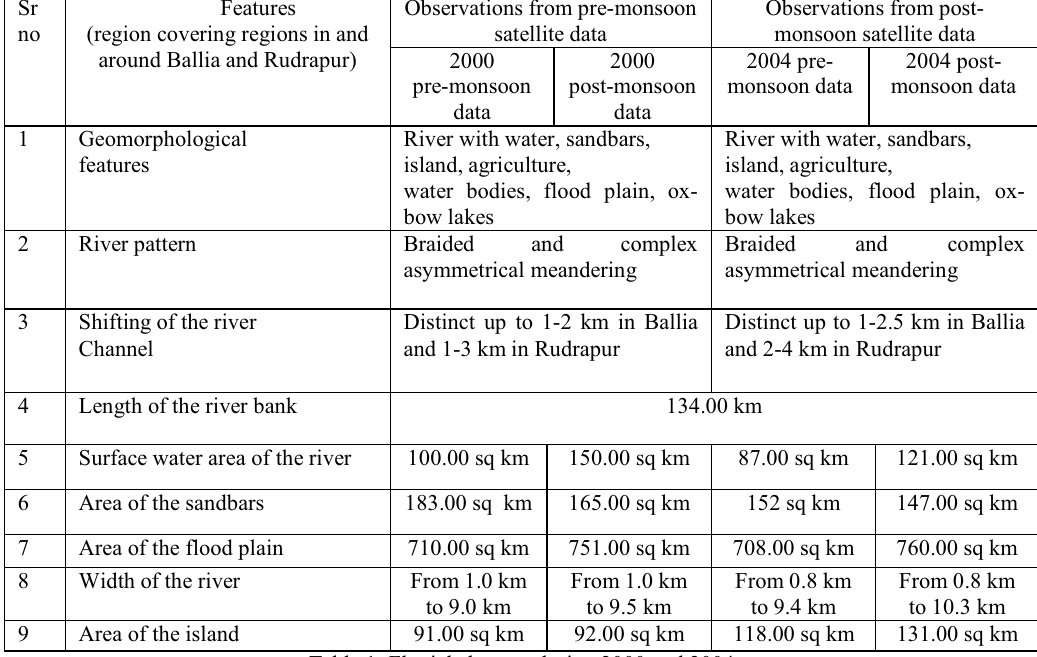
Table 1: Fluvial changes during 2000 and